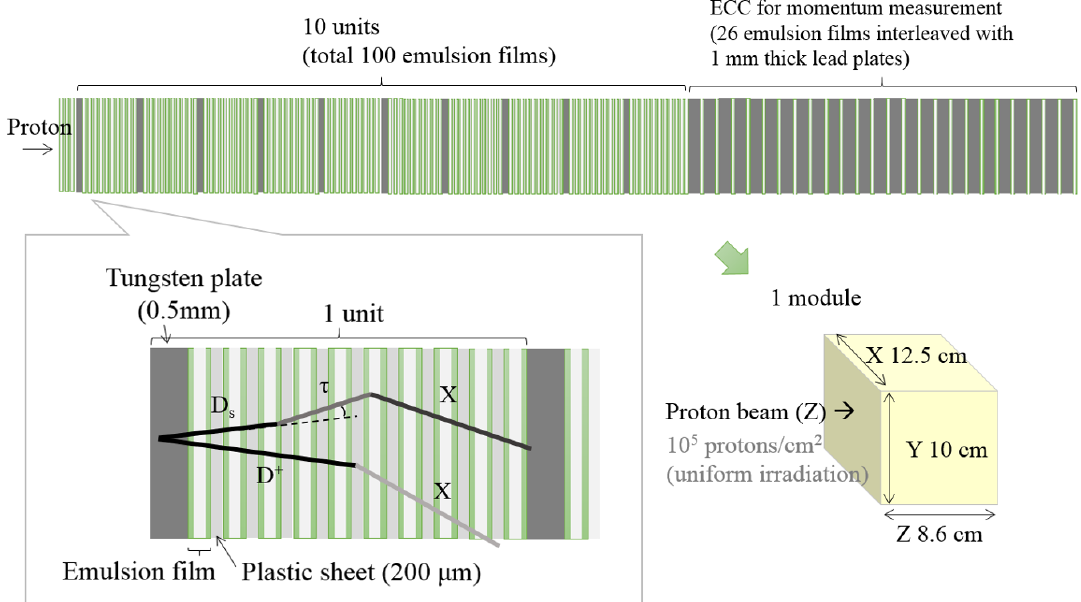
Figure 4 . Schematic view of the module structure. Each tungsten target plate followed by 10 emulsion (cid:12)lms alternated by 9 plastic sheets acting as a tracker and decay volume of 4.8 mm. The sensitive layers of emulsion detectors are indicated by green color. This basic structure is repeated 10 times, and then followed by a lead-emulsion ECC structure for momentum measurement of the daughter particles. Figure 5 . A cross-sectional view of an emulsion (cid:12)lm [39] (left), electron microscope picture of silver halide crystals (middle) and a track of a relativistic particle (10 GeV/c (cid:25) beam) (right). of 0.34 mrad (projection). With this angular resolution, one can detect 2 mrad kink with 4 (cid:27)